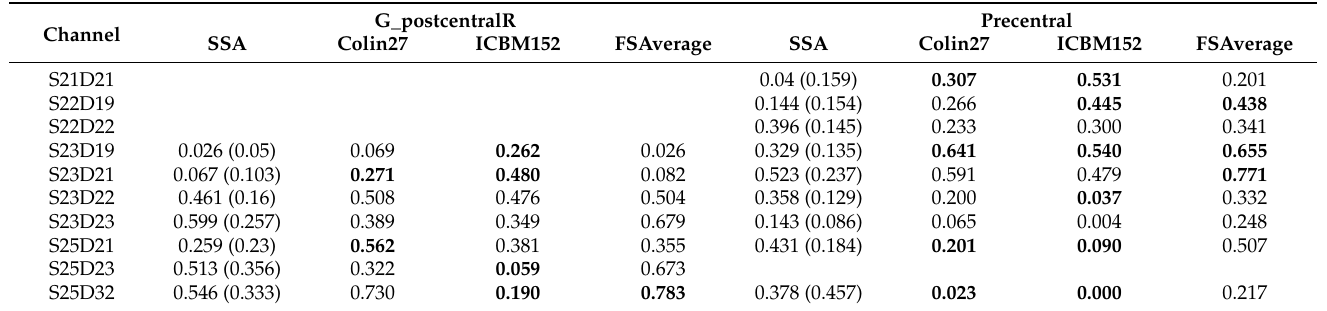
Table 7. Summary of A2Ch coefficients associated to right hemisphere Destrieux postcentral and precentral gyri. Results are reported for wavelength λ = 760 nm. Bold ABA values indicate channels presenting a 20% difference in A2Ch coefficients from the SSA median.